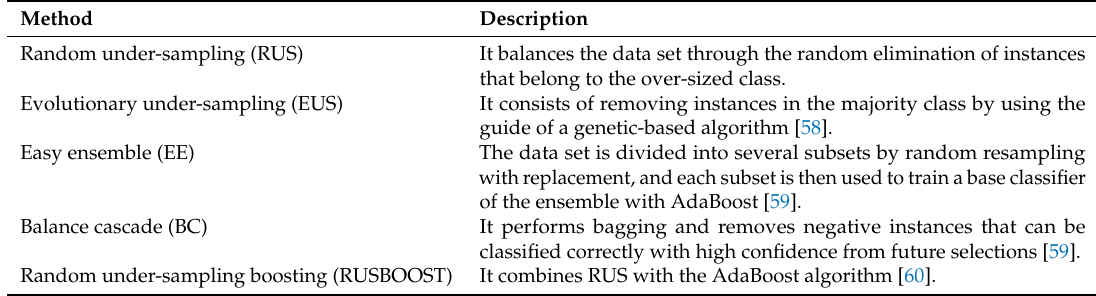
Table 2. Other under-sampling methods included in the experiments.